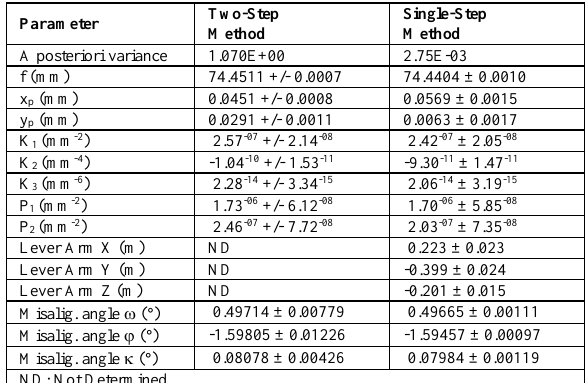
Table 3. Interior orientation and mounting parameters.